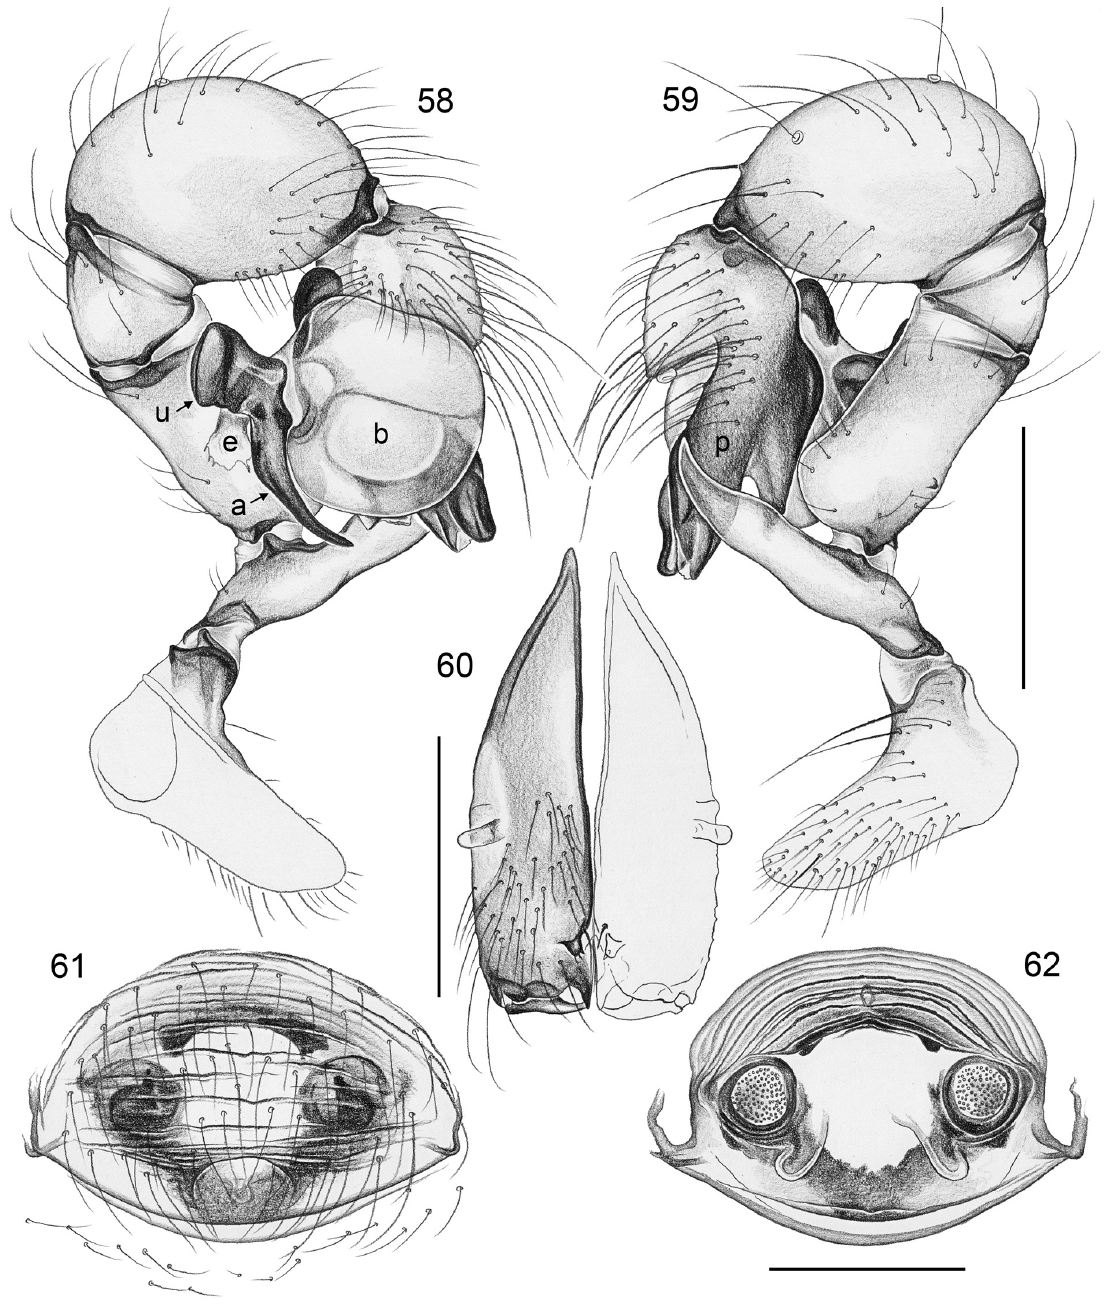
Figs 58–62. Pholcus kuhapimuk Huber, sp. nov., ZFMK Ar 15027. 58–59 . Left male palp, prolateral and retrolateral views. 60 . Male chelicerae, frontal view. 61–62 . Cleared female genitalia, ventral and dorsal views. Abbreviations: a = appendix; b = genital bulb; e = embolus; p = procursus; u = uncus. Scale lines: 0.3 mm (61–62); 0.5 mm